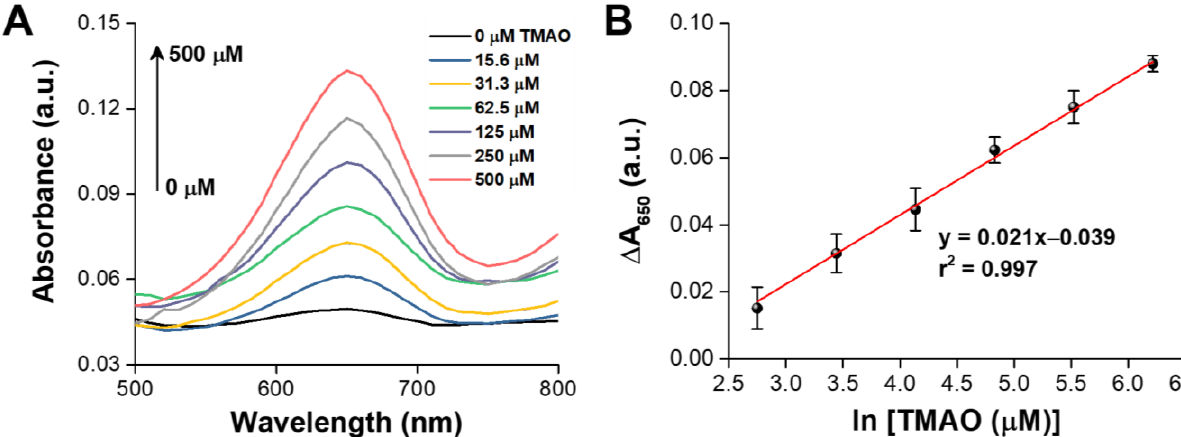
Figure 4. ( A ) Typical UV-vis absorption spectra of TMB for the detection of TMAO at various concentrations using the colour-switch method based on PAH@MnO 2 ; ( B ) the linear calibration curve between A 650 and the TMAO concentration. The values are means ± SD ( n = 6).